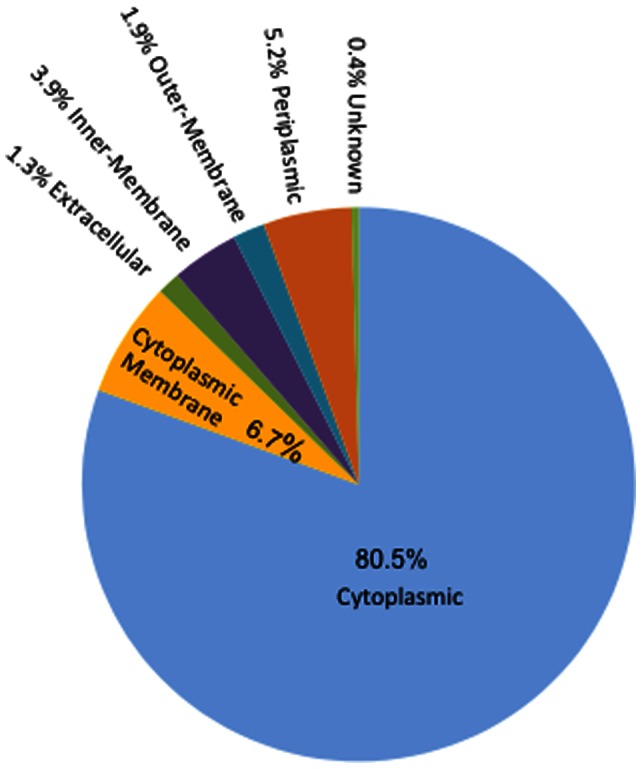
Protein localisation prediction based on PSORT (see material and method for detail).The complete set of proteins has been used for localisation distribution.